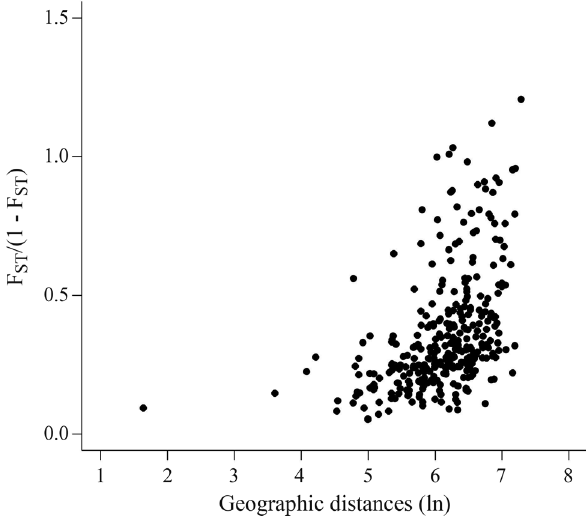
Figure 4 - Relationship between transformed F ST and logarithm of geo- graphic distances for the 25 populations of “Baru” tree. Notice that trans- formationdidnotproducealinearrelationship,supportingpreviousanaly- ses showing that IBD does not apply in this